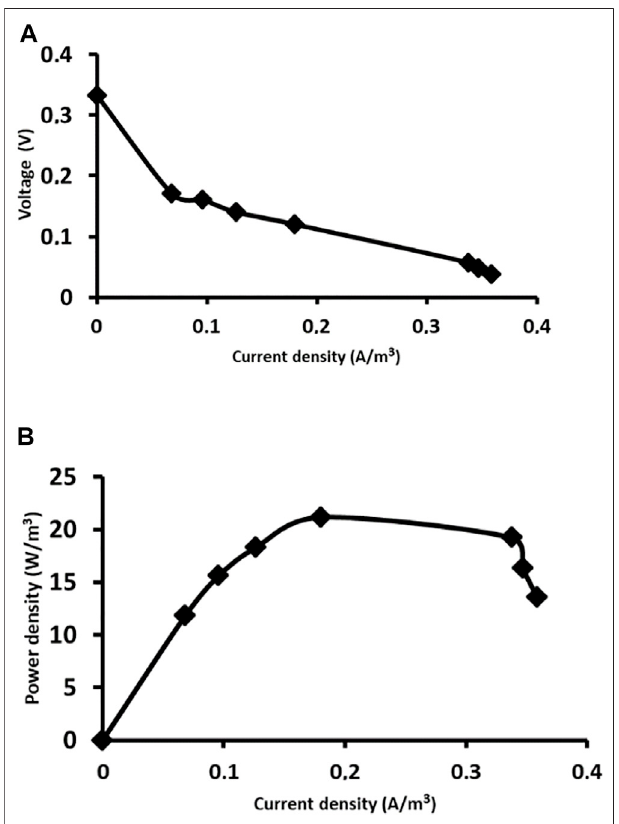
FIGURE 5 | Electrochemical performance of MFC2 at day 30: (A) Polarization curve; (B) Power density